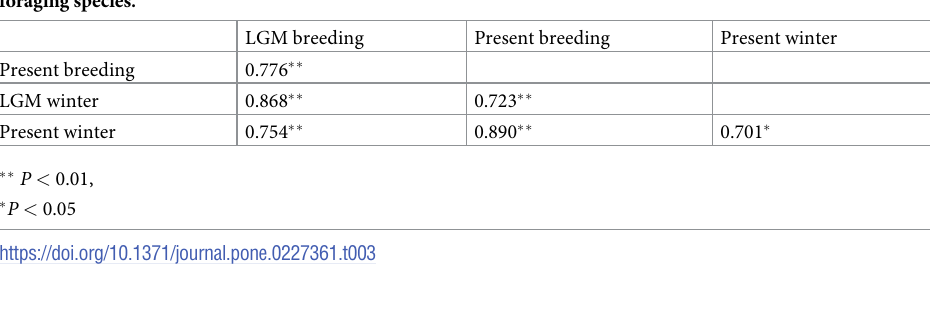
Table 3. Pearson product-moment correlation coefficients between measures of niche breadth for a guild of bark- foraging